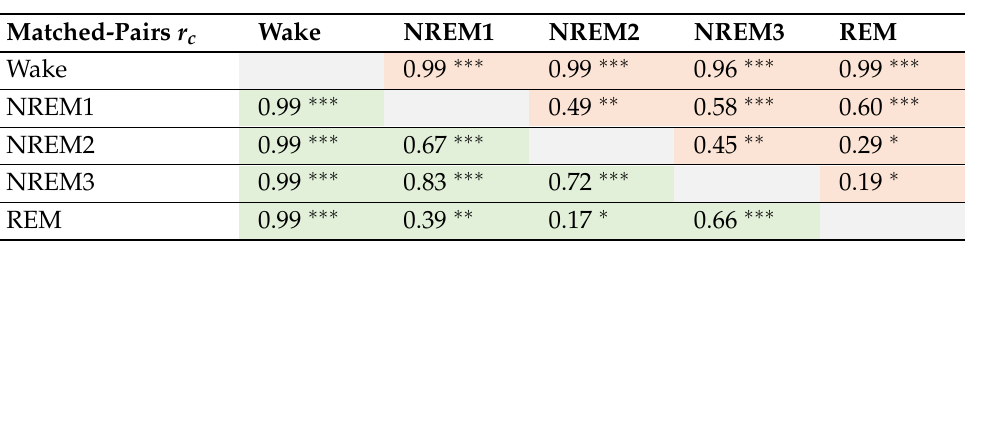
Table 1. The matched-pairs r c values of proportions of high-quality PPG between different sleep stages obtained by using ECG-guided (orange background) and TM-based algorithms (green back- ground). p < 0.001 and r c < 0.30 is marked ∗ , p < 0.001 and r c ≥ 0.30— ∗∗ , p < 0.001 and r c ≥ 0.50— ∗∗∗